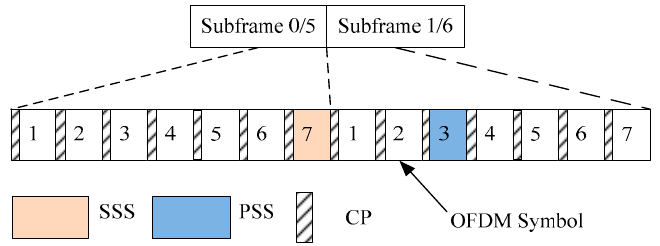
Figure 6. Illustration of the primary synchronization signal (PSS) and secondary synchronization signal (SSS) in an LTE 1800 subframe.